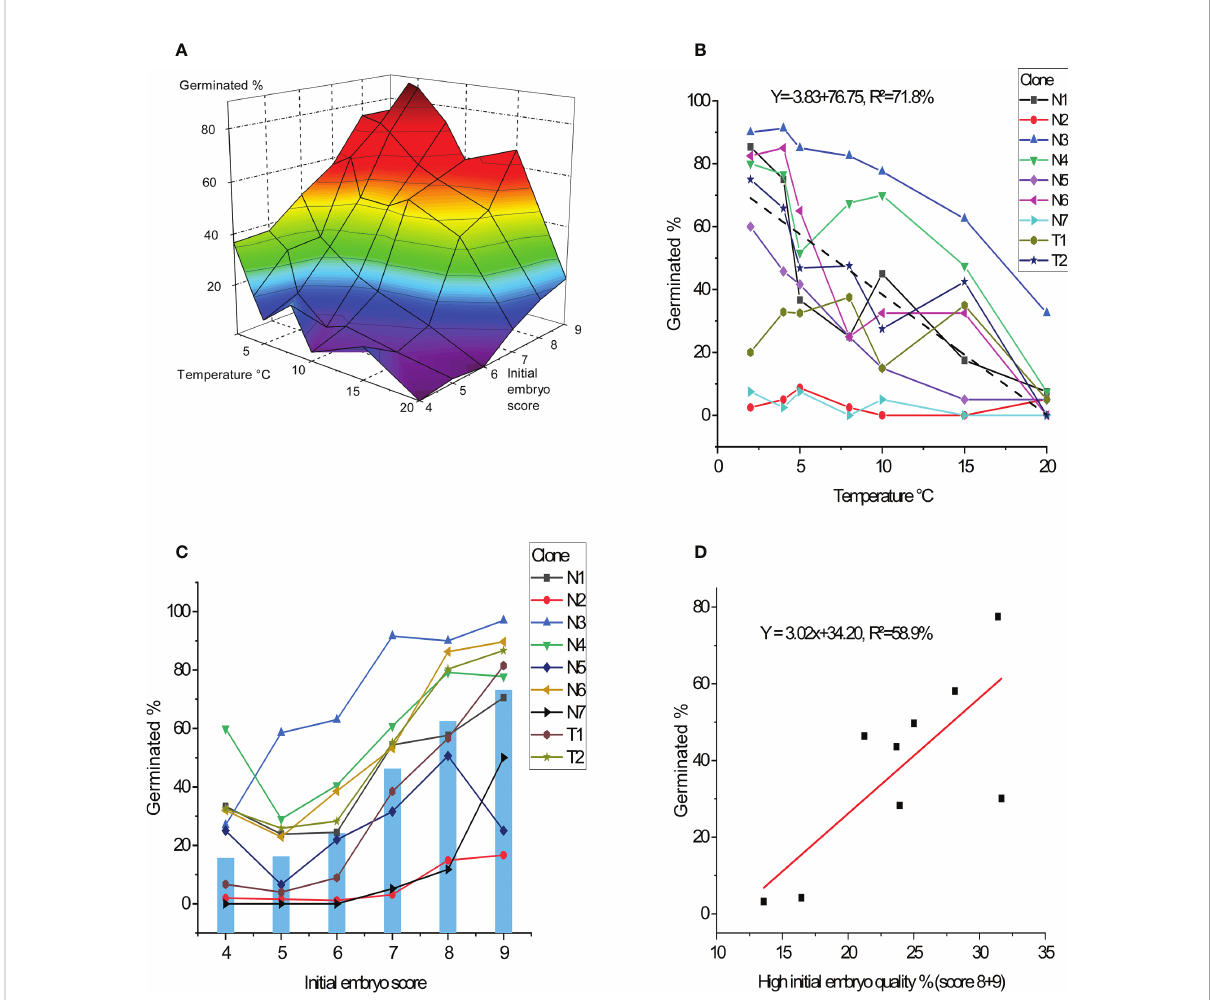
FIGURE 3 Percentage of germinated embryos after 11 weeks. (A) Average germination frequency in percentage across all nine clones in response to germination temperature and initial embryo quality score. (B) Average germination for each clone in percentage as response to temperature treatments (average performance of clones showed by dashed line). (C) Average germination for each clone in percentage as response to initial embryo quality score (average across clones showed in bars). (D) Average germination for each clone in percentage as function of frequency of percent high quality initial embryos (percent score 8 +